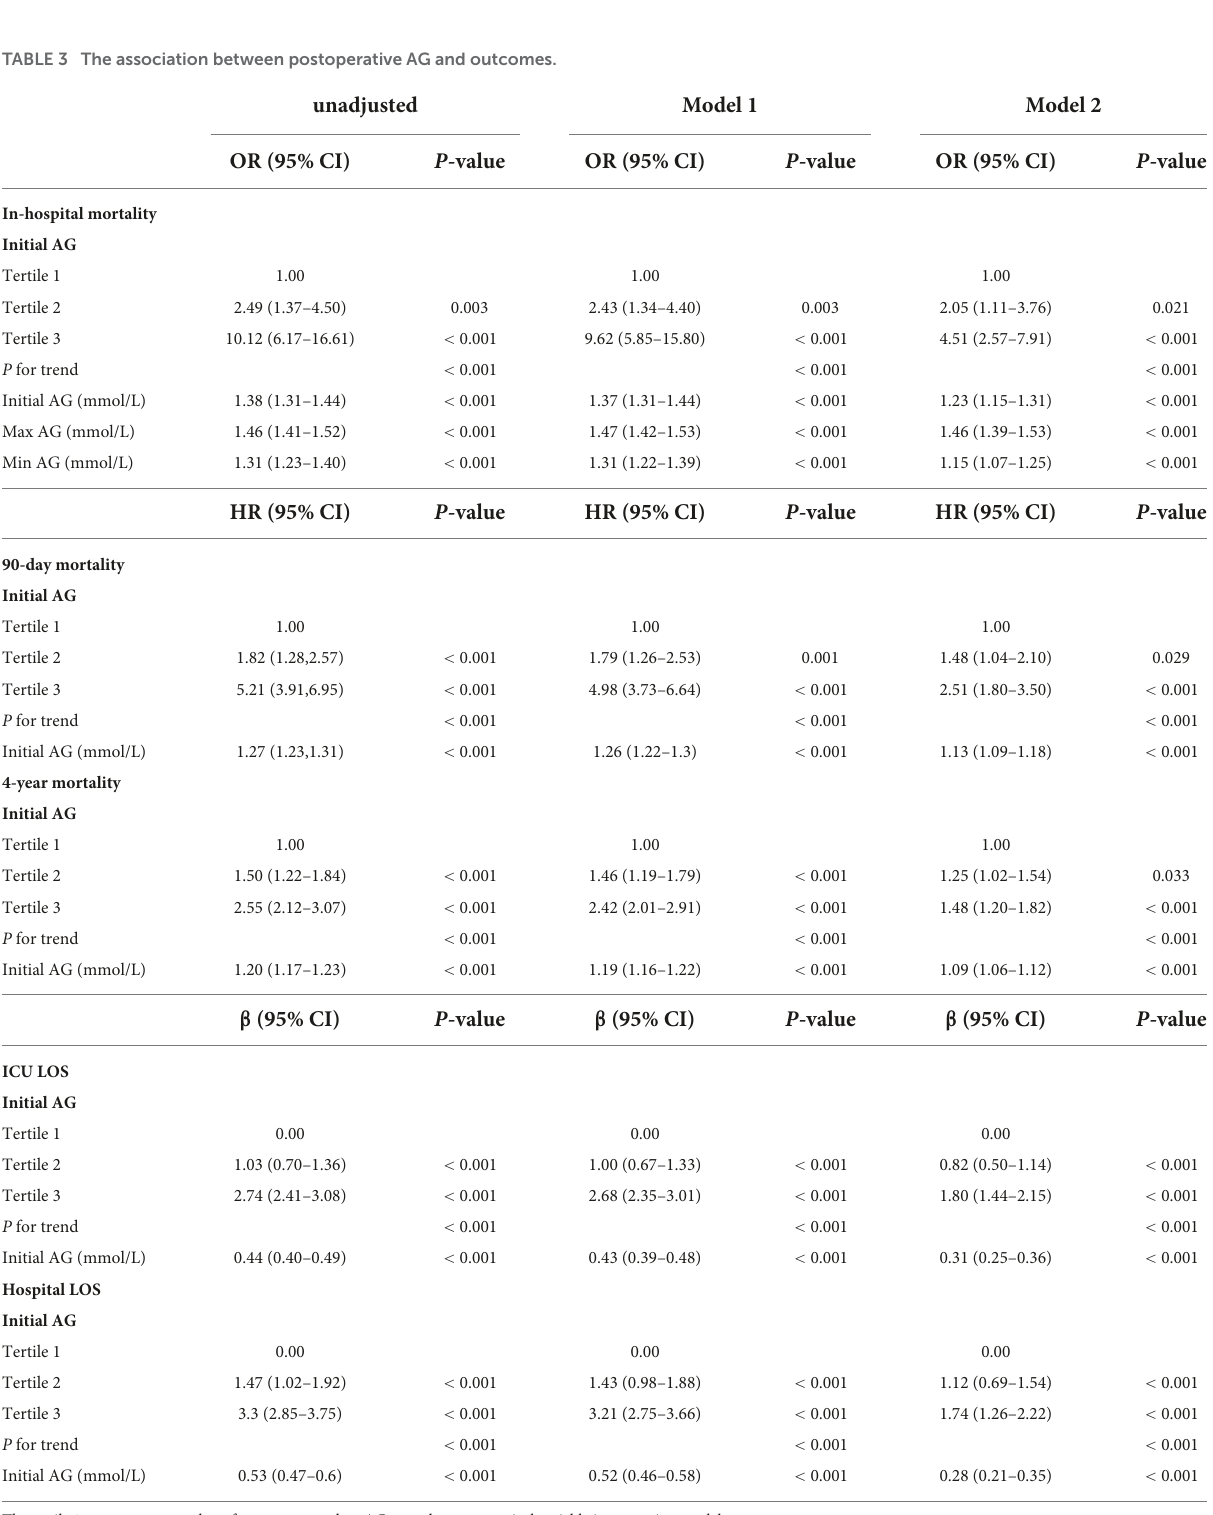
TABLE 3 The association between postoperative AG and